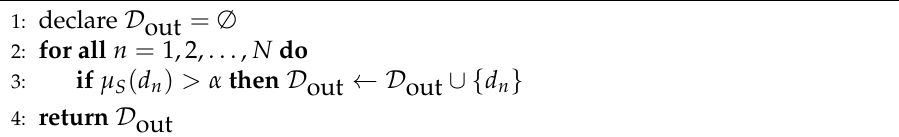
Algorithm 3 Recognizing outliers detected with Algorithm 1.